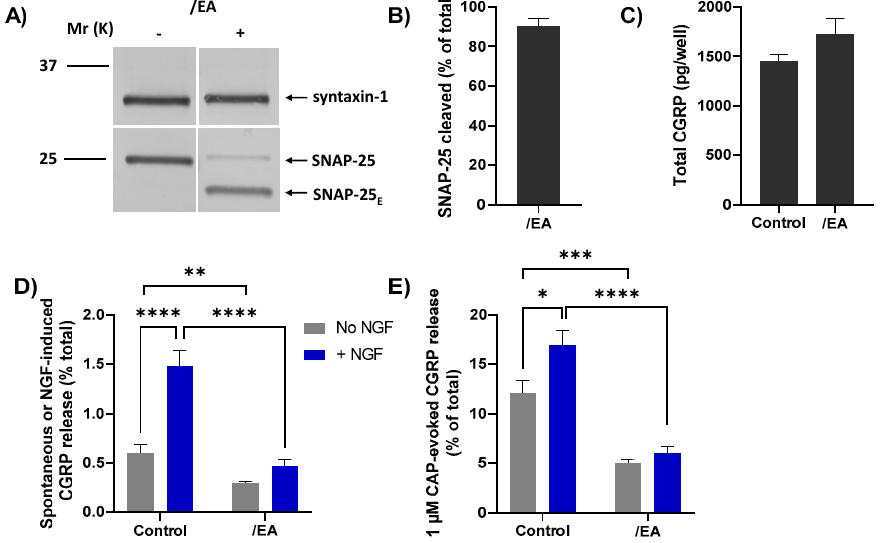
Figure 6. Chimera/EA effectively inhibits 1 µ M CAP-evoked CGRP release from starved TGNs, and